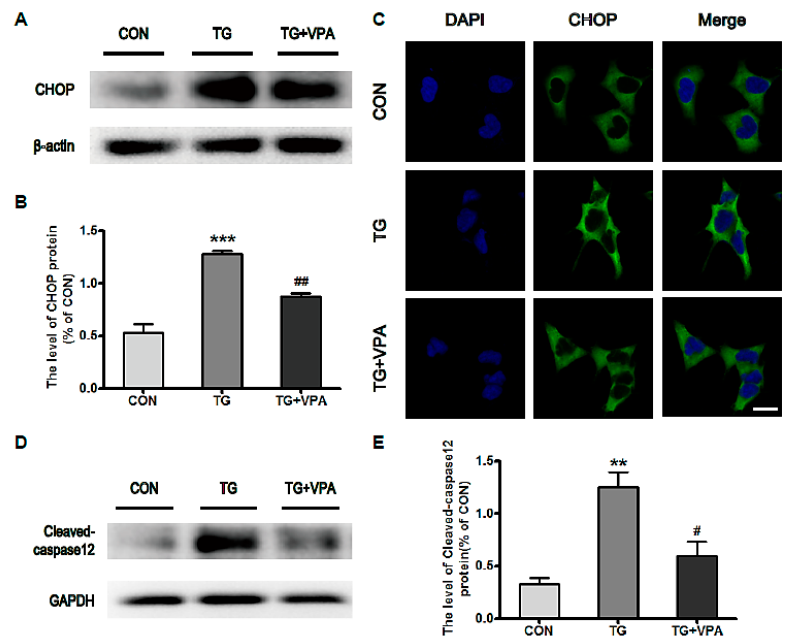
Figure 4. VPA inhibits ER stress-induced apoptosis in SH-SY5Y cells. ( A , D ) The level of CHOP and cleaved-caspase12 in the control, TG, and TG and VPA groups. n = 5; ( B , E ) Densitometric analysis of CHOP and cleaved caspase-12, # p < 0.05, ## p < 0.01 versus the TG group; ** p < 0.01, *** p < 0.001 versus the control group; ( C ) Immunofluorescence of CHOP ( green ); the nuclear ( blue ) was labelled with DAPI. Magnification was 40×. Data are the mean values ± SEM, n = 3. Int. J. Mol. Sci. 2017 , 18 , 315 2.4. VPA Inhibits ER Stress-Induced Apoptosis and Up-Regulates the Ratio of Bcl-2/Bax in SH-SY5Y Cells